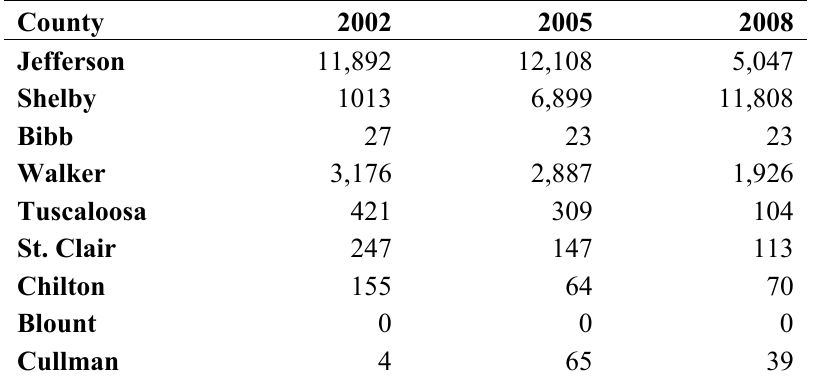
Table 3. Annual emissions from non-mobile sources for each county in the study